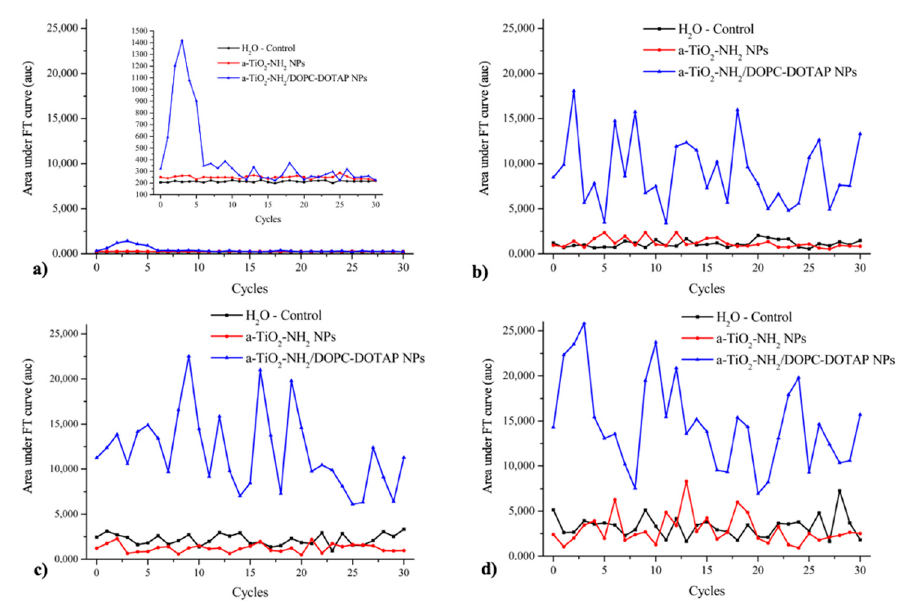
Figure 9. Area under the FT curve computed from the signal recorded through a focused piezo-detector used as cavitometer to analyze the cavitation of water and a-TiO 2 -NH 2 based NPs suspensions. The analyses were performed using the following conditions: 1 MHz, 100% of DC, 1 min of irradiation with ( a ) 0.3 W / cm 2 of US output power; ( b ) 0.6 W / cm 2 of US output power; ( c ) 0.9 W / cm 2 of US output power; ( d ) 1.2 W / cm 2 output power.